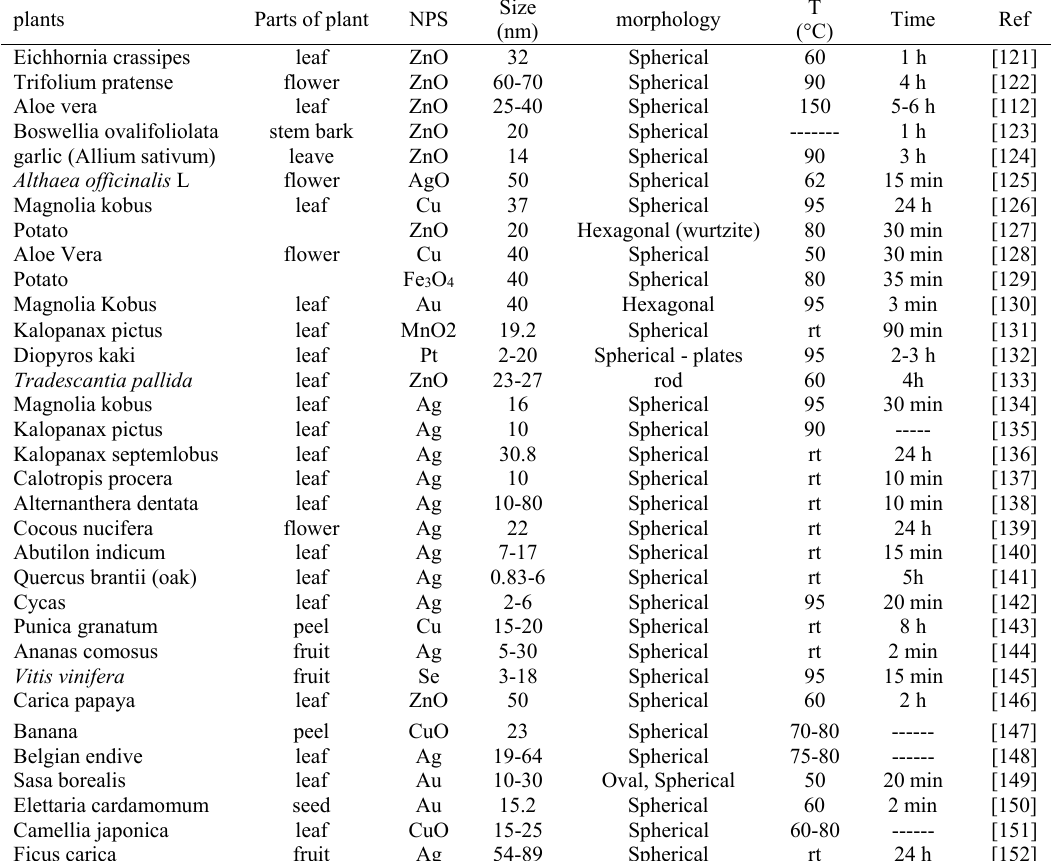
Table 1: The synthesis of NPs using plant extracts by modifying parameters such as temperature and time.